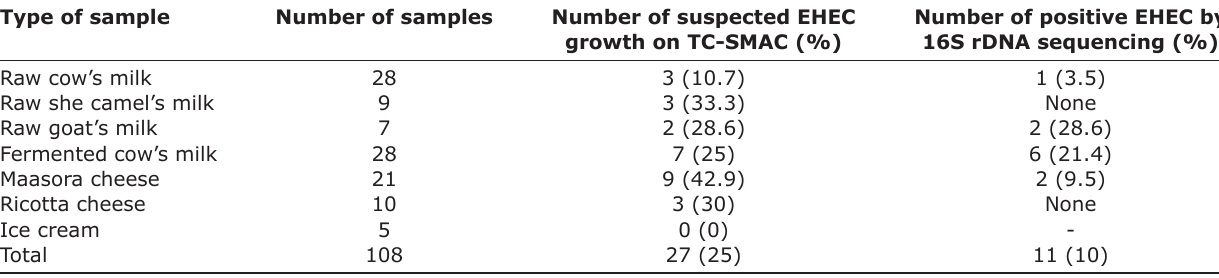
Table-1: Isolation and molecular identification of suspected EHEC in processed samples. Type of sample